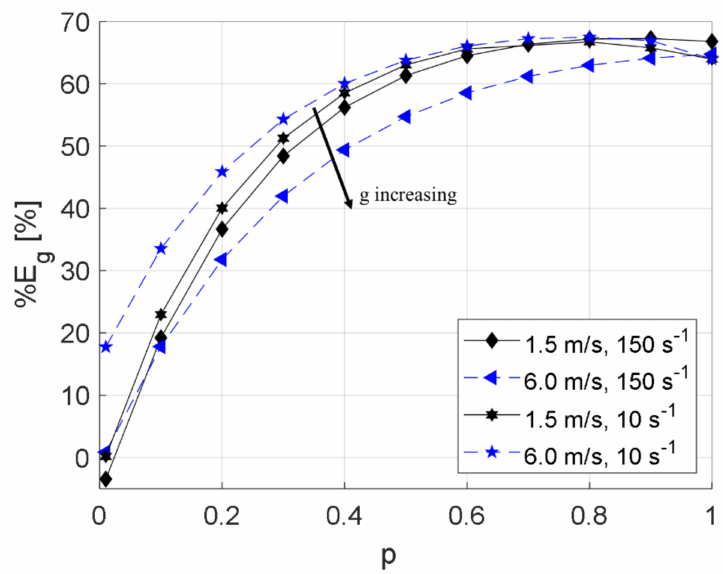
Figure 14. The relative error between global estimate and local breakup frequency, %E g , as a function 1.5 m/s, black , and 6.0 m/s, blue ) and two breakup frequency levels (10 s − 1 and 150 s − 1